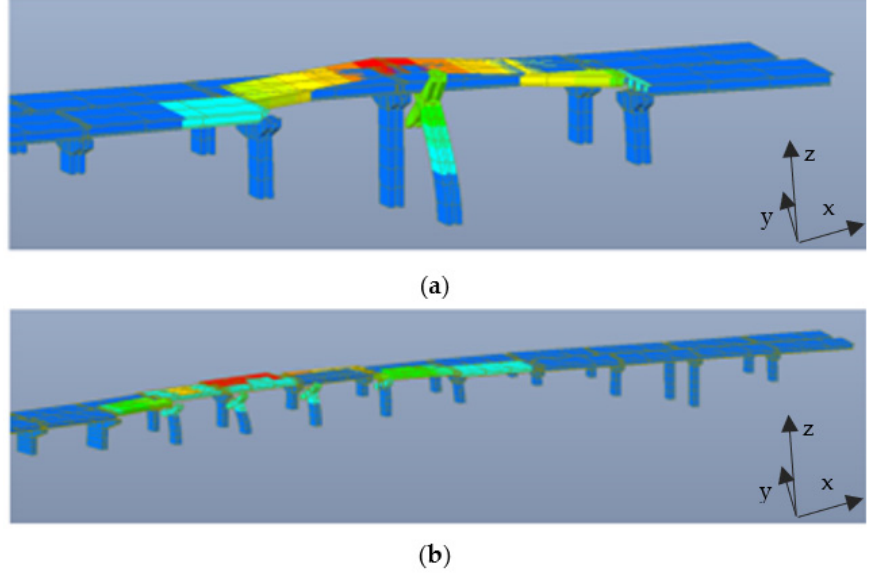
Figure 13. ( a ) Tenth mode Y ‐ direction (pile 14S). ( b ) Thirteenth mode Y ‐ direction (south piles of the central sector of the bridge).